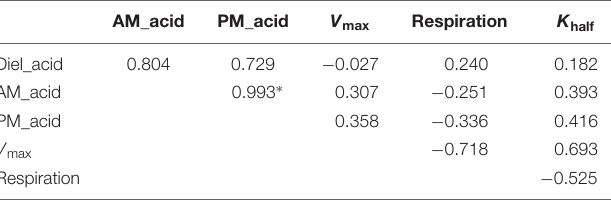
TABLE 3 | The Pearson correlation between six carbon-related leaf traits in the eight